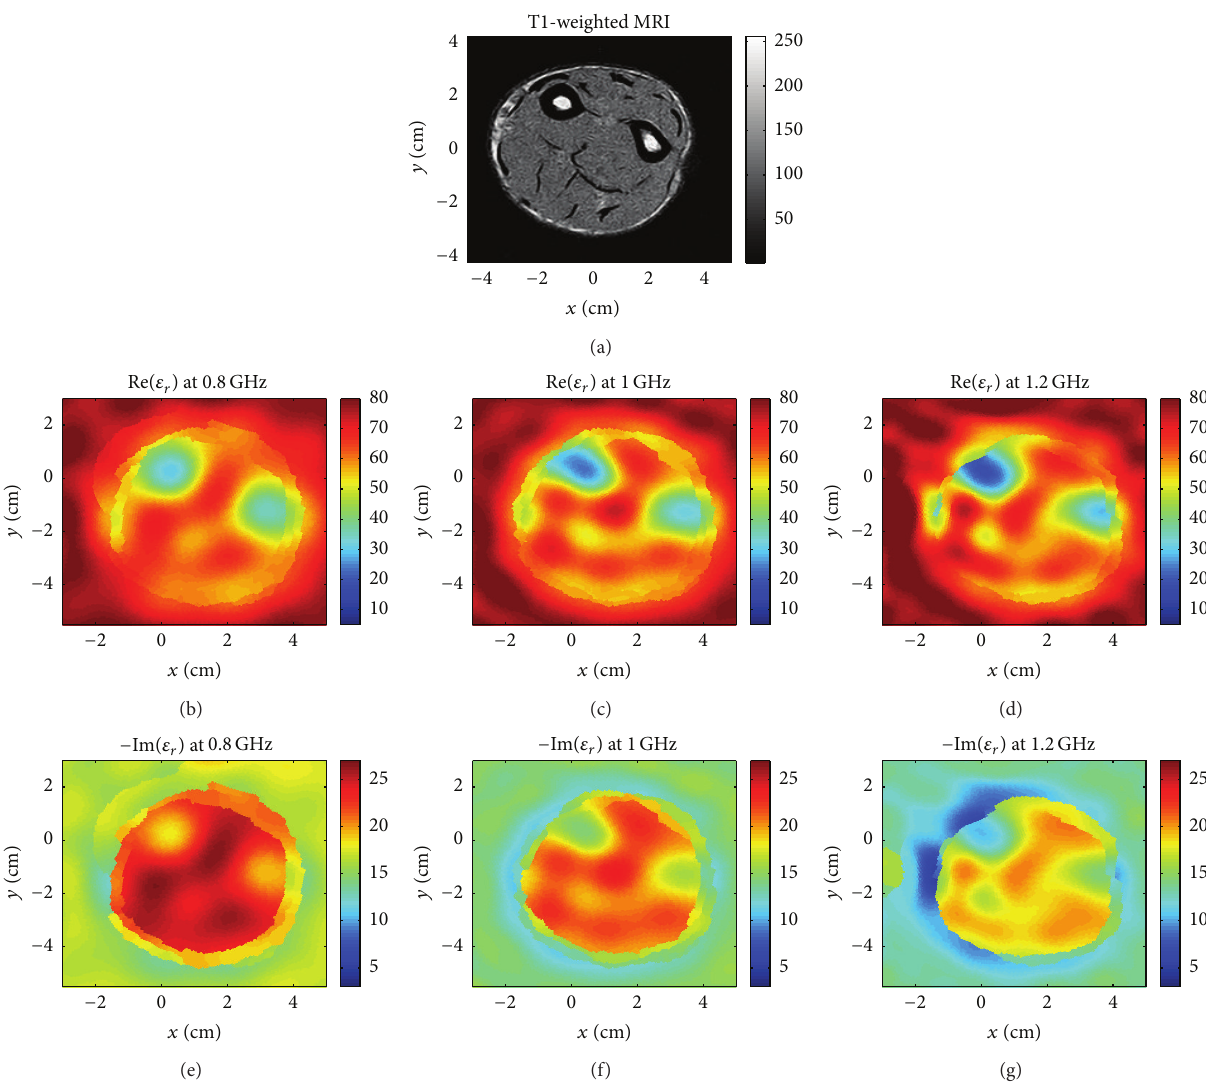
Figure 4: Volunteer 1: (a) the T1-weighted MRI image. MWI reconstructions of the relative complex permittivity real and imaginary components at (b), (e) 0.8 GHz, (c), (f) 1GHz, and (d), (g) 1.2